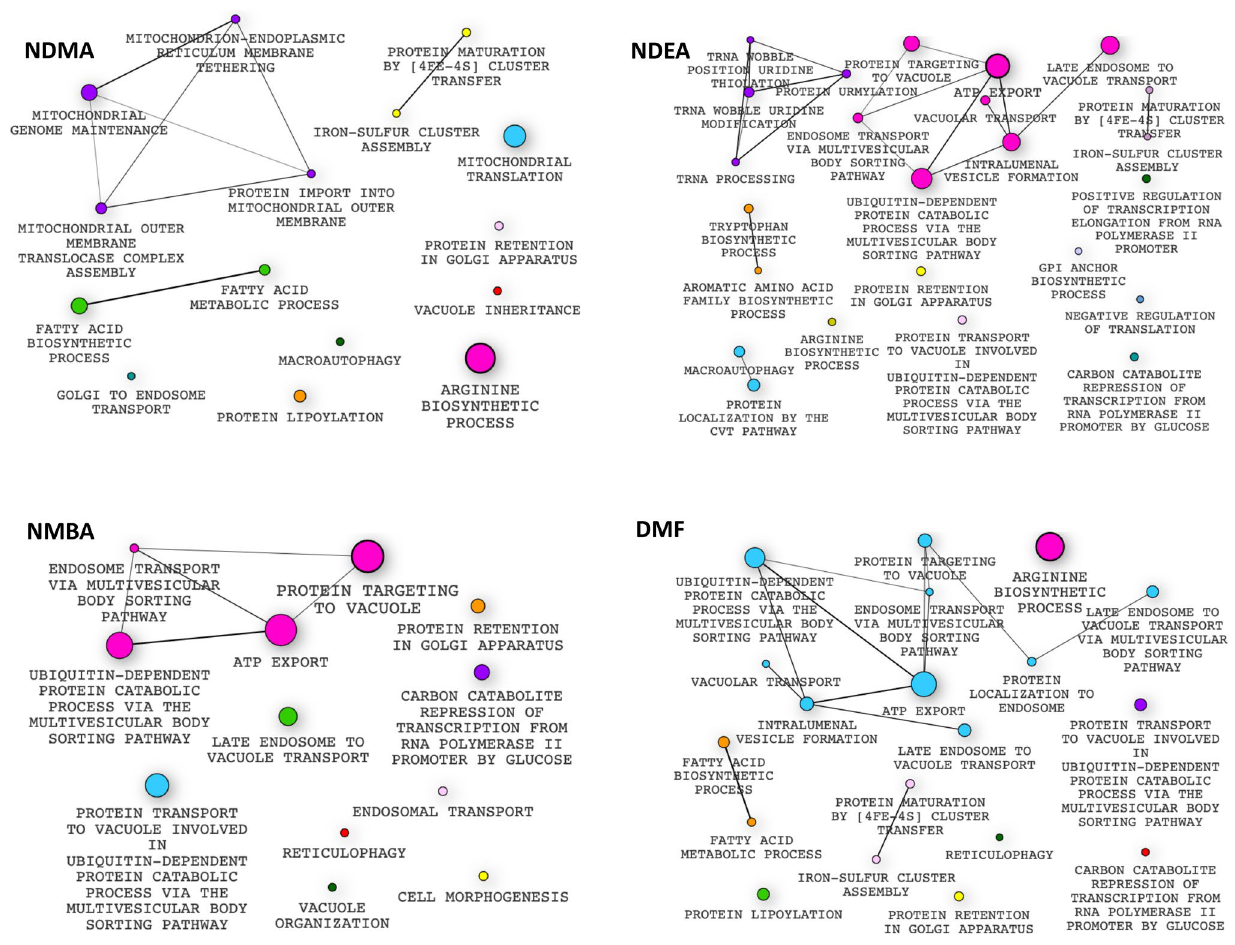
Figure 3. Gene Ontology enrichment profiles for the nitrosamines and DMF. Genes lacking in the sensitive strains were enriched for certain biological processes including; NDMA: arginine biosynthesis, fatty acid metabolic process, mitochondrial genome maintenance and macroautophagy. NDEA: protein transport, vacuolar transport, arginine biosynthesis, negative regulation of translation and macroautophagy. NMBA: protein transport, protein targeting to vacuole and cell morphogenesis. DMF: arginine biosynthesis, protein transport and iron–sulfur cluster assembly. Each node represents a gene set while the node size represents the number of genes in the gene set. The edge represents overlap between gene sets while the edge width represents the number of genes that overlap between connected gene sets. Not all pathways enriched at significant FD score are shown, e.g. septin ring assembly for NDEA, etc. Enrichment profiles were generated using the Bioconductor v3.12, https:// www. bioco nduct or.